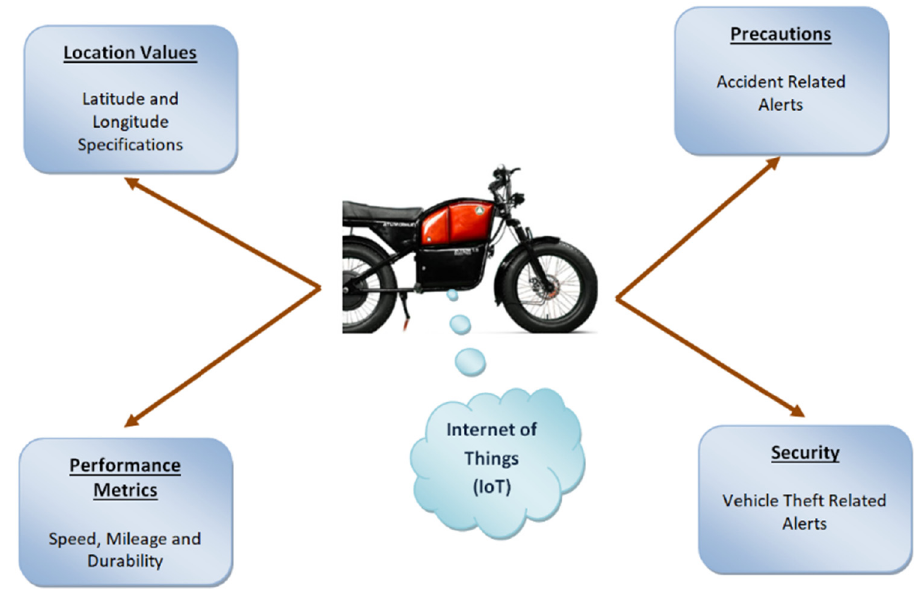
Figure 1: IoT association with electric motorcycle.